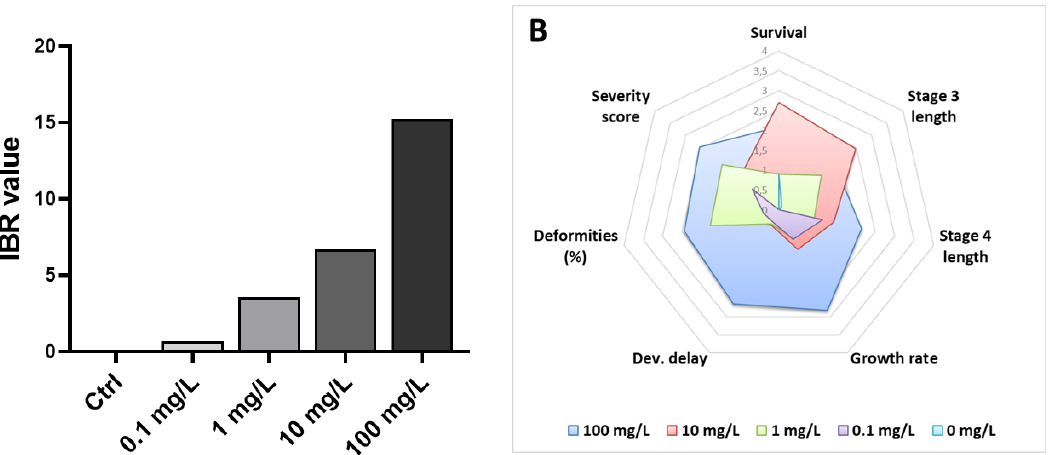
Figure 5. Integrated biomarker response index calculated based on C. riparius endpoints measured following 7 days of exposure to increasing GO concentrations ( A ). Representation of endpoint contributions to the calculated index for each experimental condition ( B ).